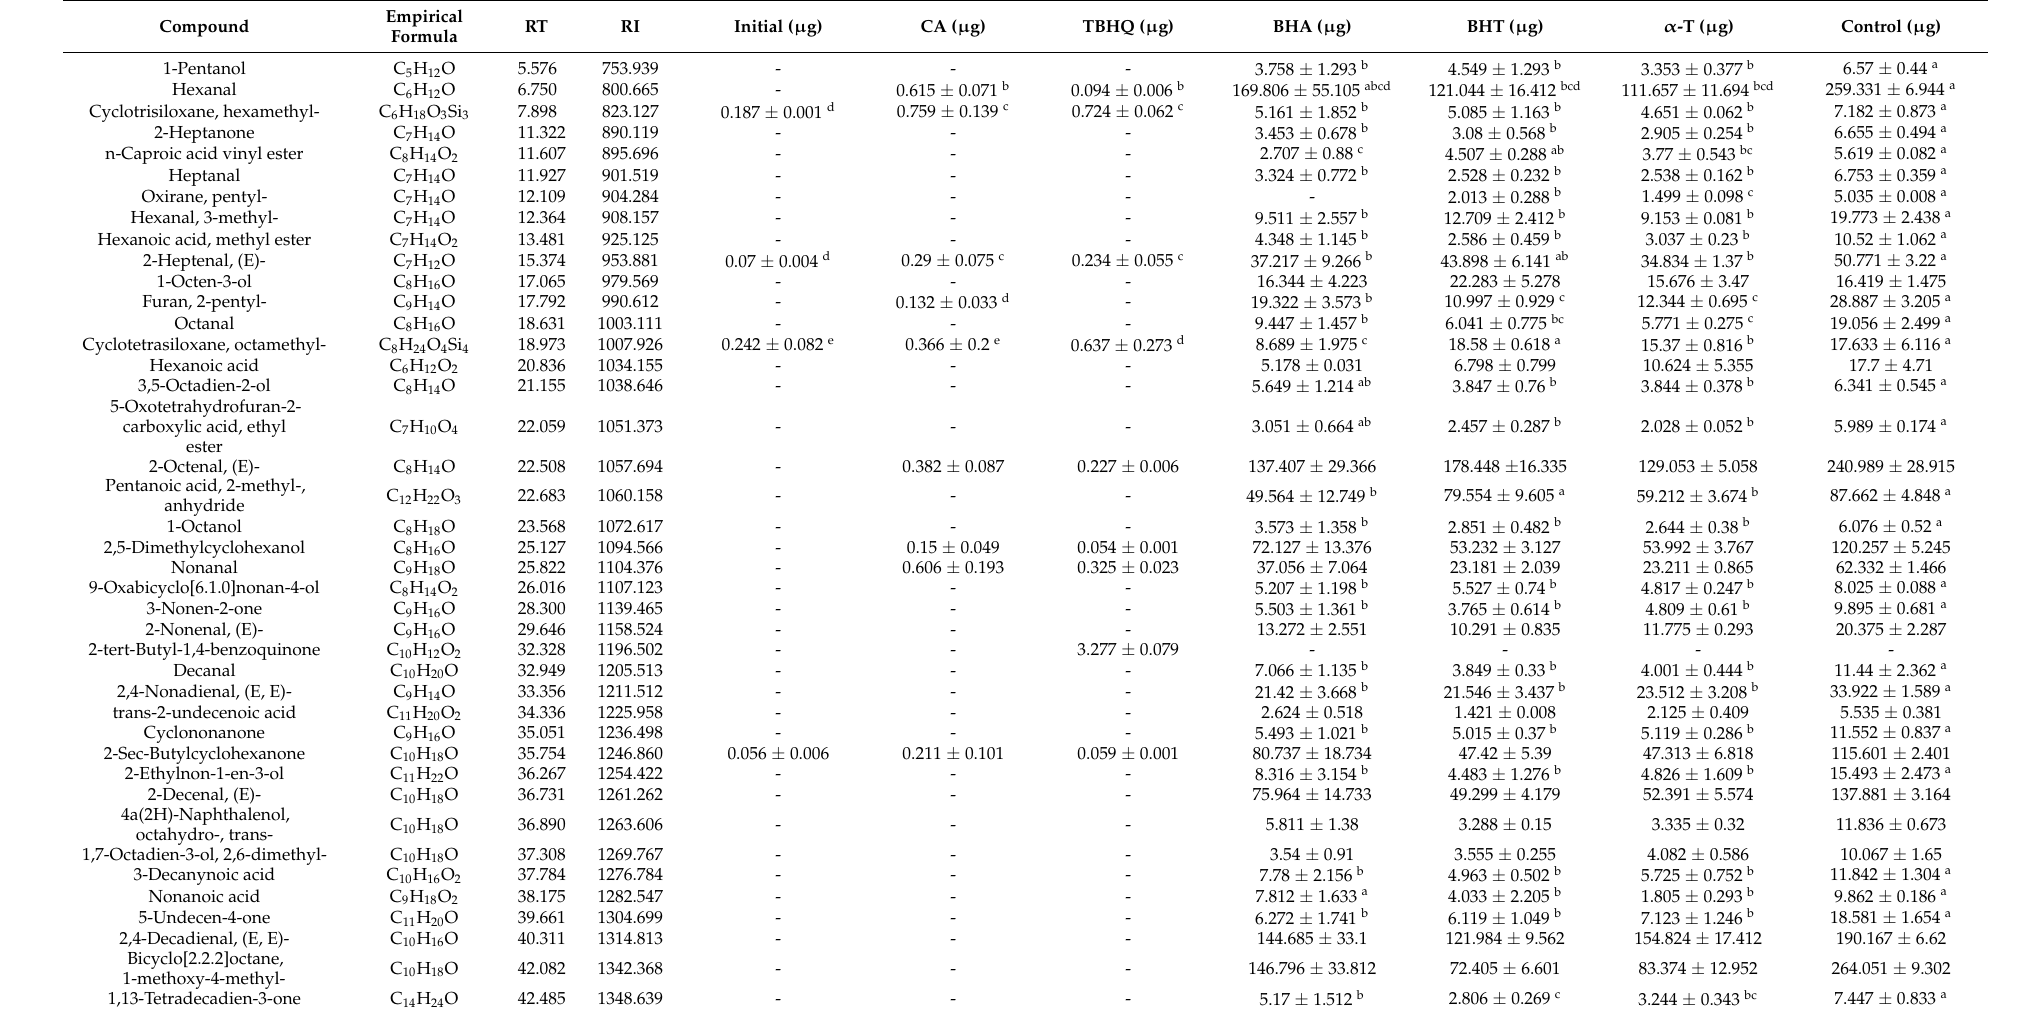
Table 1. Volatile lipid oxidation products of 1 g Aoil at the beginning and storage at 60 ◦ C for 30